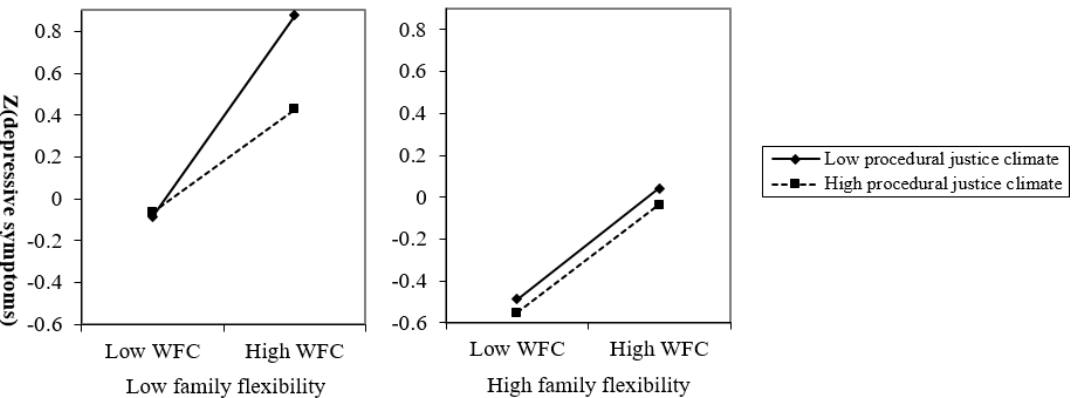
Figure 3. The moderating e ff ect of procedural justice climate in the association between work-to-family conflict (WFC) and depressive symptoms was influenced by family flexibility. The interaction pattern of WFC × Distributive justice climate × Family flexibility was similar to Figure 3.